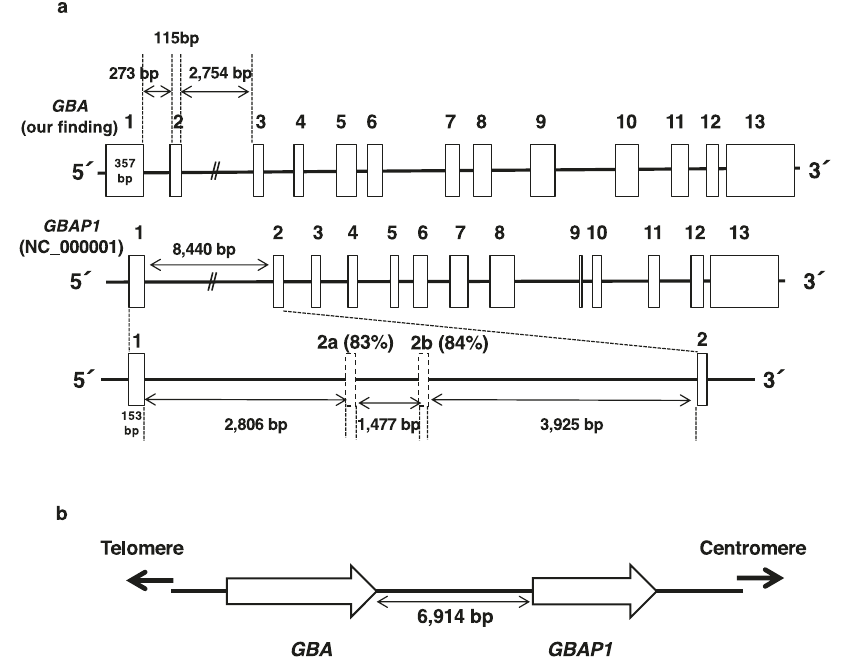
Fig. 3 Gene structure and chromosomal position of GBA and GBAP1 . a Structural comparison of GBA and GBAP1 . The white boxes indicated exons. Based on the exon 1 and 2 sequences of GBA , upstream exons of GBAP1 were predicted through a homology search of the genome database and are depicted with dashed-line boxes. b The positional relationship between GBA and GBAP1 in chromosome 1. White arrows indicate the direction of GBA and GBAP1